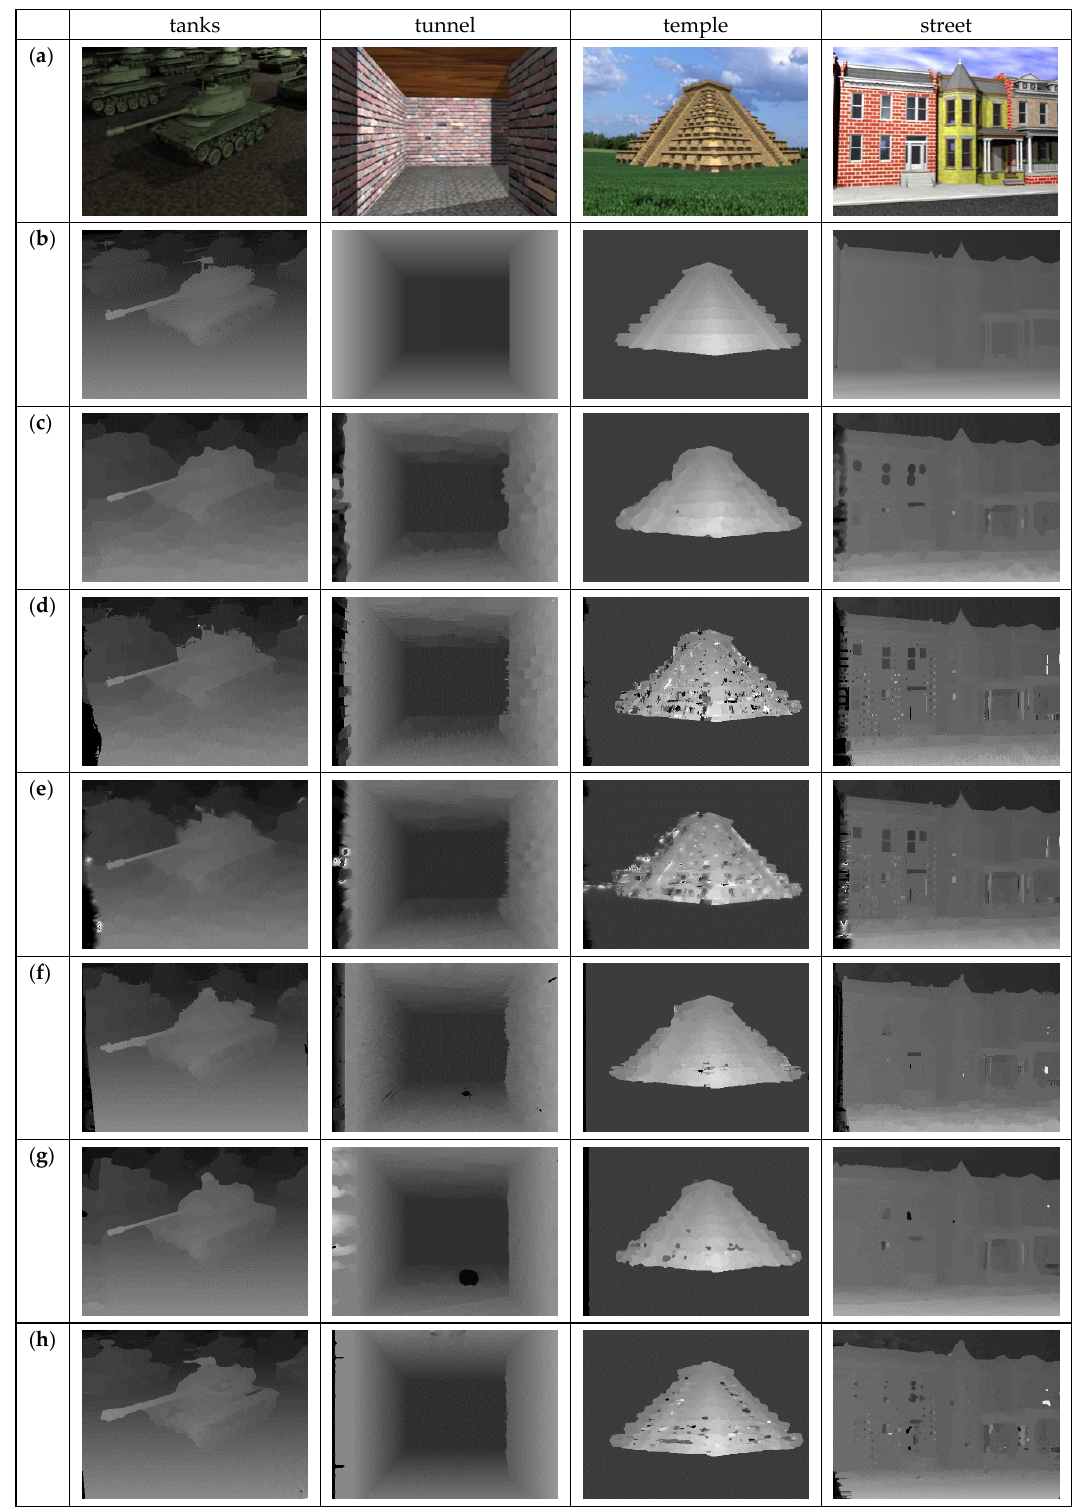
Figure 13. Refined results for 95th frame [9]: ( a ) original image; ( b ) ground truth; ( c ) our proposed method; ( d ) method of Zhang et al. [5]; ( e ) method of Lin et al. [3]; ( f ) method of Jung et al. [12]; ( g ) method of Zhan et al. [14]; and ( h ) method of Yang et al. [7].